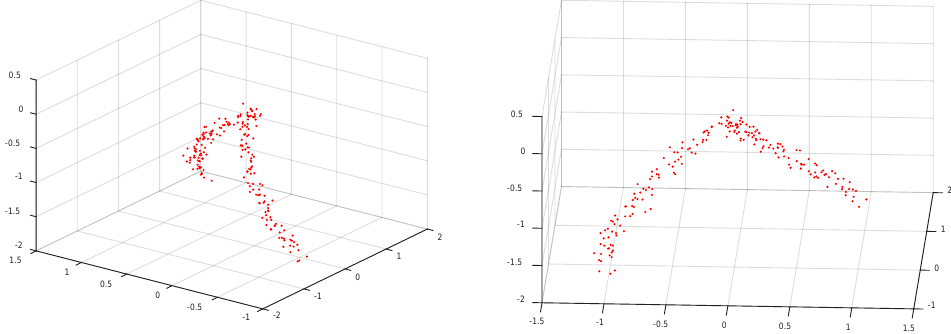
Figure 2. Illustration of simulated data from two different viewpoints.